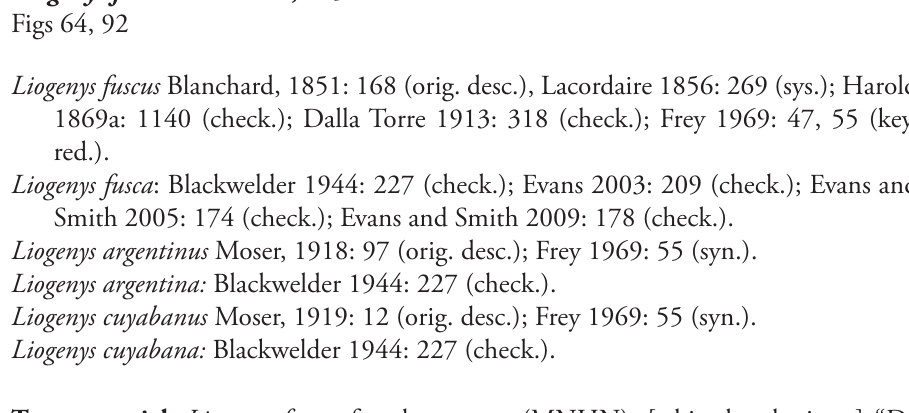
Liogenys fuscus Blanchard, 1851: 168 (orig. desc.), Lacordaire 1856: 269 (sys.); Harold 1869a: 1140 (check.); Dalla Torre 1913: 318 (check.); Frey 1969: 47, 55 (key,